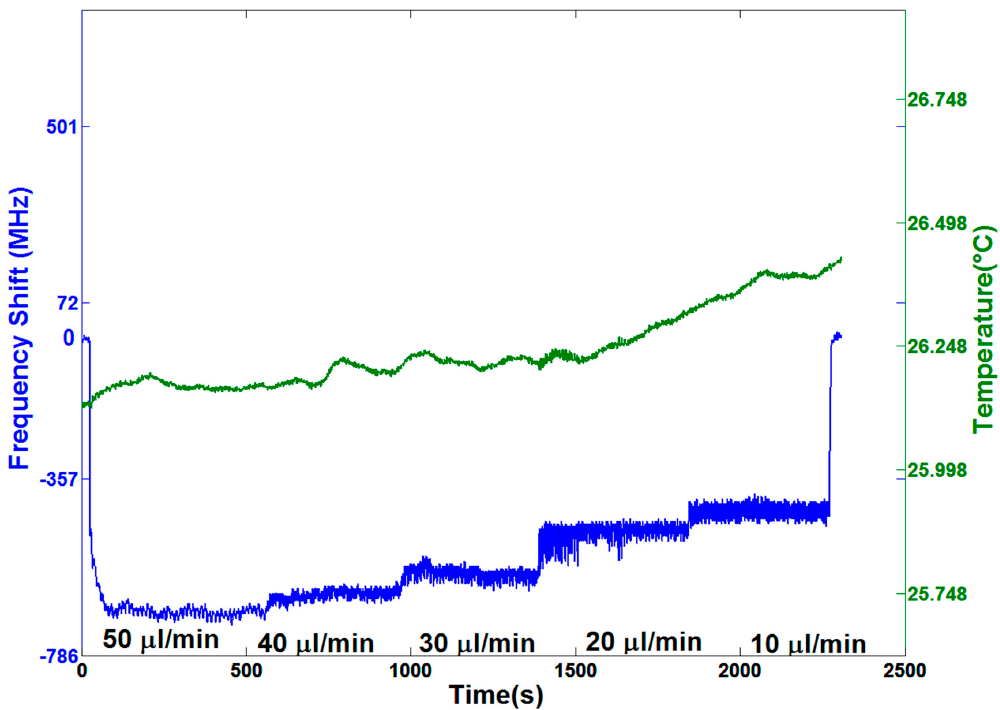
Figure 4. Resonance frequency shifts and temperature fluctuations versus elapsed time, with water flowing at different pumping speeds, starting with no flow and ranging from 50 µL/min down to 10 µL/min, produced by a peristaltic pump. There is a different frequency shift for each pumping speed. Furthermore, the fluctuation parameter σ decreases with the increase of the speed, which might originate from the low pass frequency behavior of the Tygon tubing.